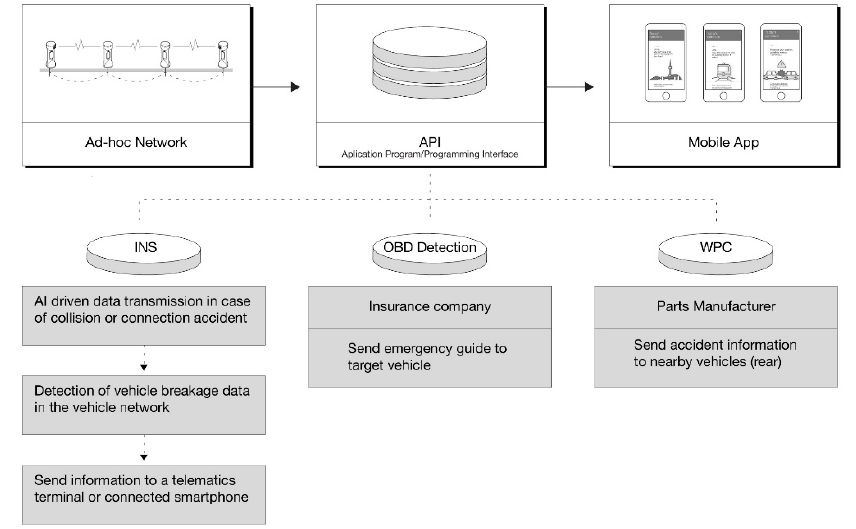
Figure 11. Data flow: vehicle guidance system, from sensor robots to in-vehicle service [27]